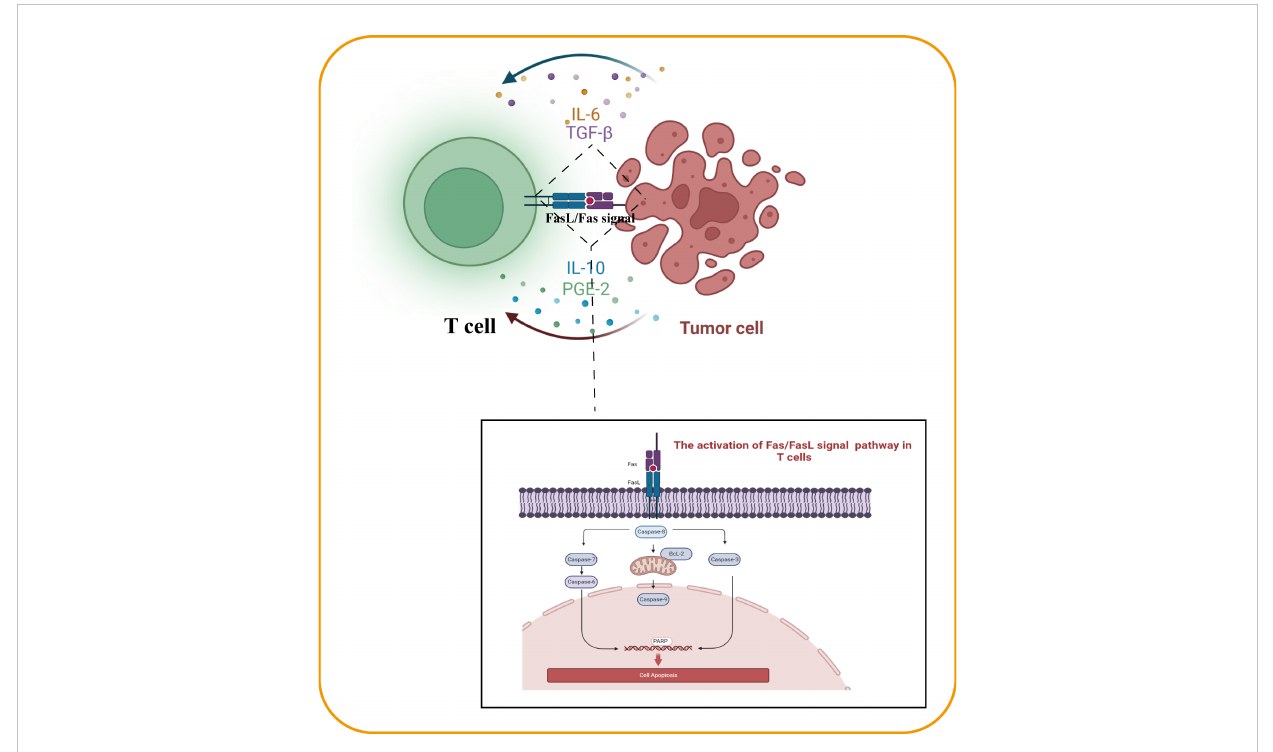
FIGURE 1 The anergy in EGCT in fi ltrating